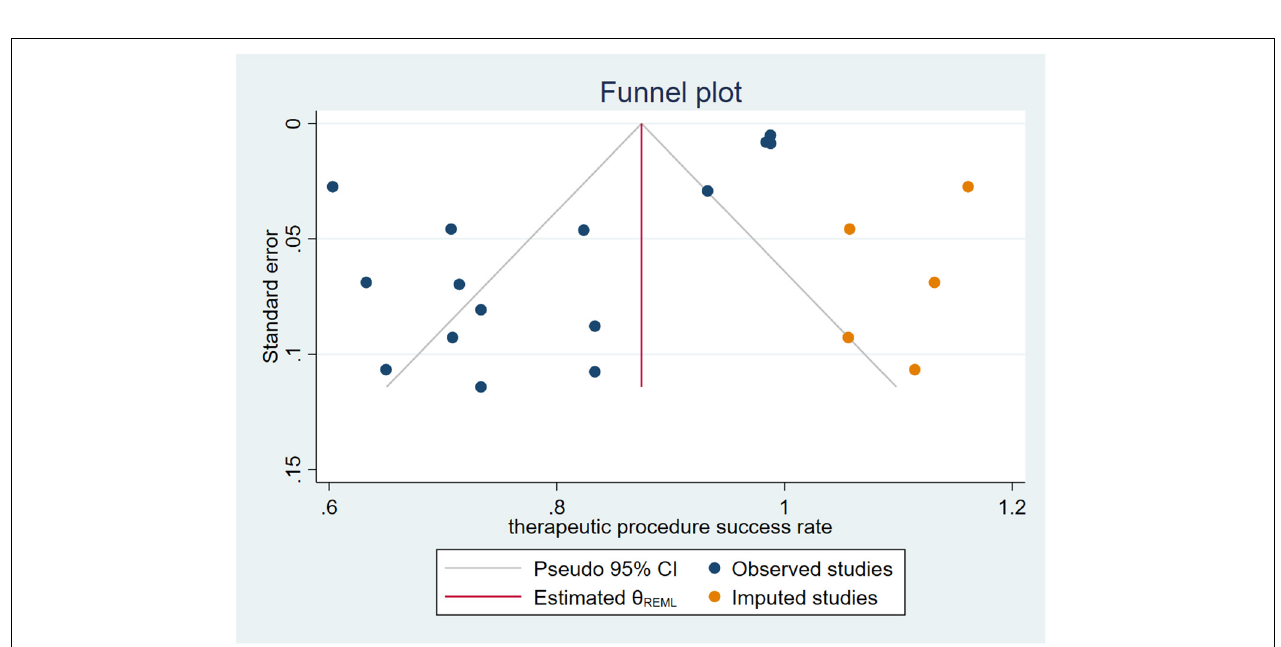
FIGURE 5 | Non-parametric trim-and-fill analysis of publication bias of therapeutic procedure success rate.